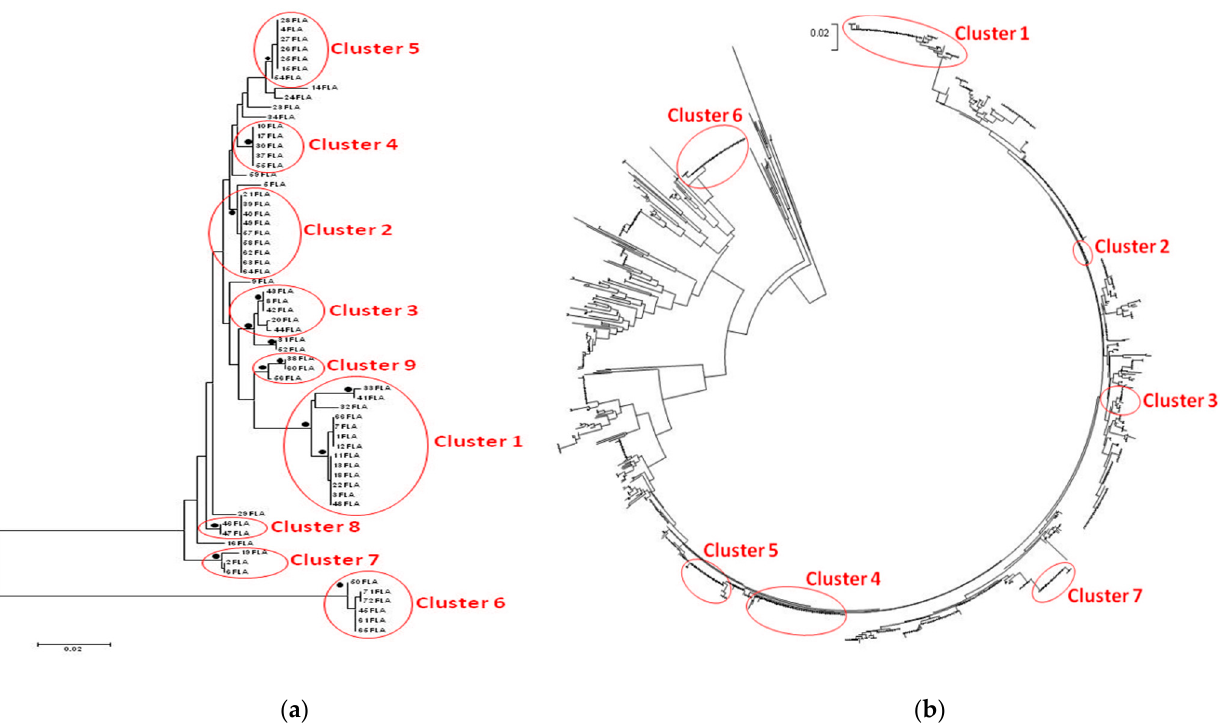
Figure 1. Campylobacter jejuni phylogenetic trees. Bullets represent clades, which had bootstrap values >75% of permuted trees. ( a ) The analysis involved 64 sequences. Most of the sequences were organized in nine significant clusters supported with high bootstrap values. ( b ) The optimal tree with the sum of branch length = 4.34019783 is shown.